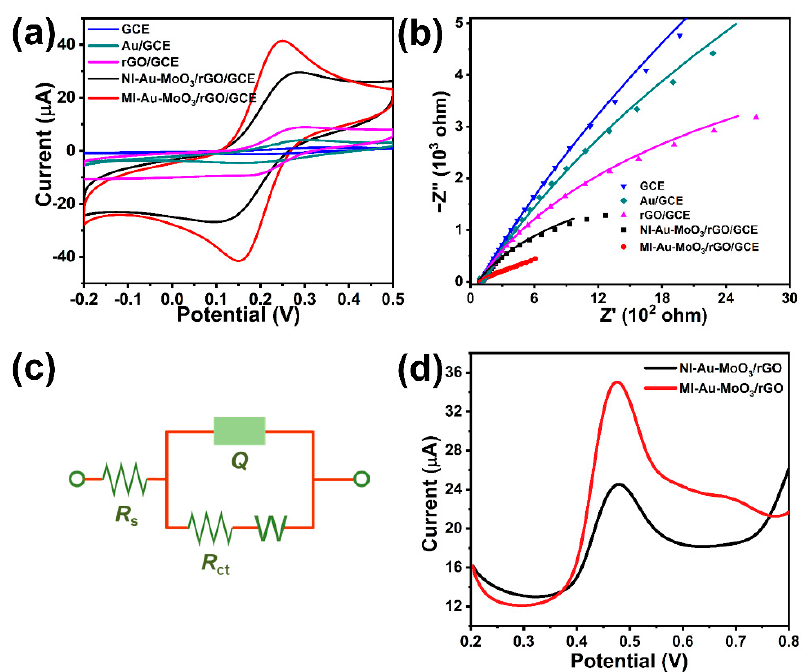
Figure 2. CVs ( a ) and EIS ( b ) of the samples in 2.5 mM K 3 [Fe(CN) 6 ]/K 4 [Fe(CN) 6 ] solution containing 0.1 M KCl. ( c ): Equivalent circuit was used for simulating EIS. ( d ): DPVs of the samples in 0.1 M phosphate buffer (pH 7.0) containing 0.10 mM BPA.